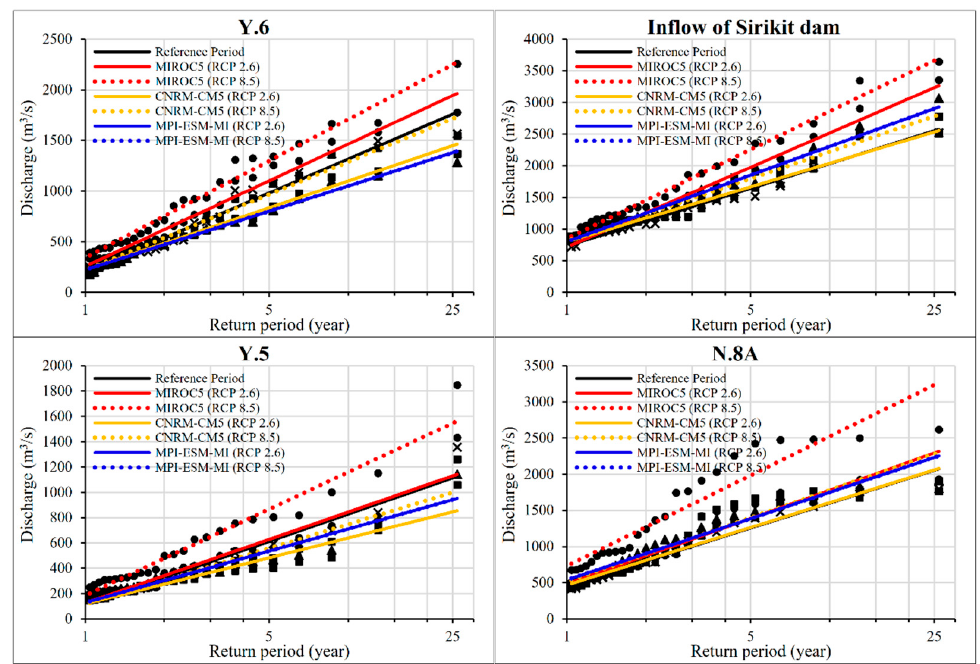
Figure 13. Return period of peak discharge in the intermediate future (2046–2070) under scenarios RCP 2.6 and RCP 8.5 compared with the reference period.